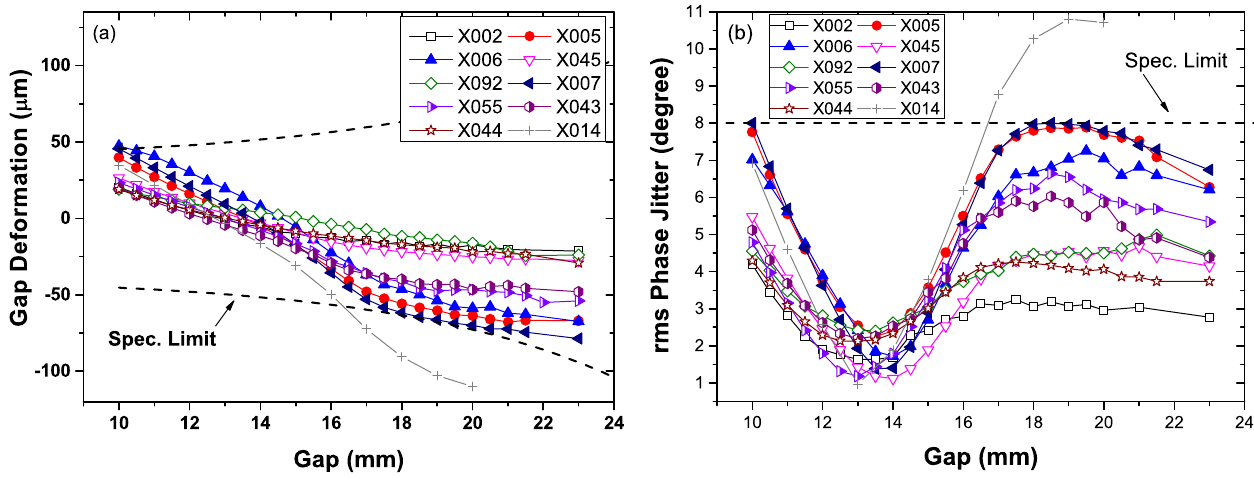
FIG. 7. The status of ten representative U40 undulator segments. (a) Gap dependence of deformation. (b) Gap dependence of rms phase jitter. Specification limits are indicated.